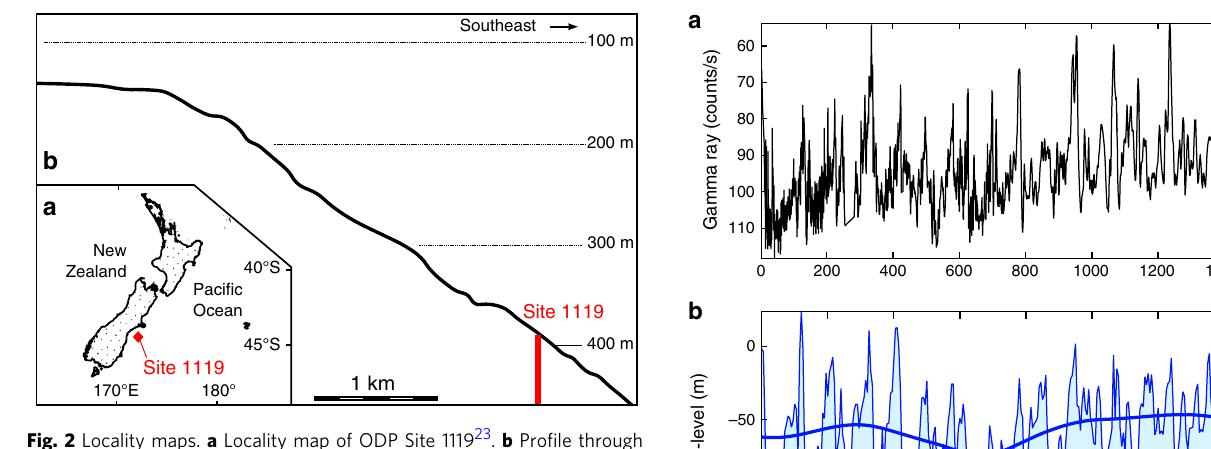
Fig. 2 Locality maps. a Locality map of ODP Site 1119 23 . b Pro fi le through Site 1119 showing present-day water depth 20